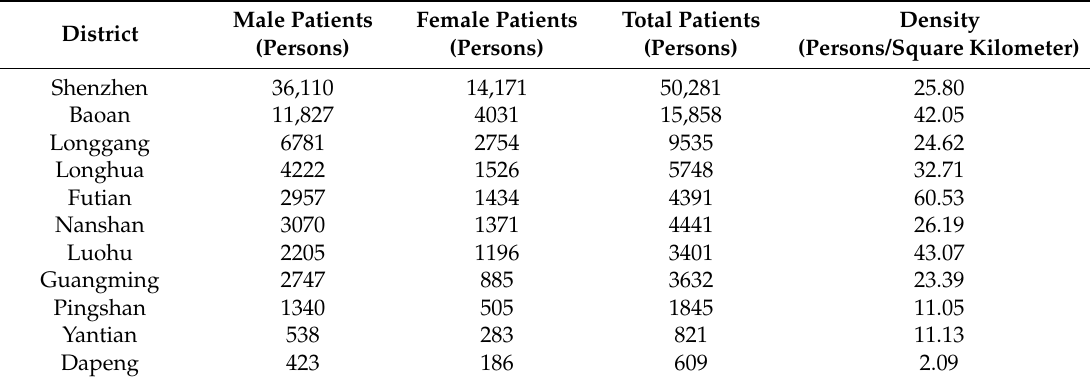
Table 1. Numbers of trauma cases in each district in Shenzhen.